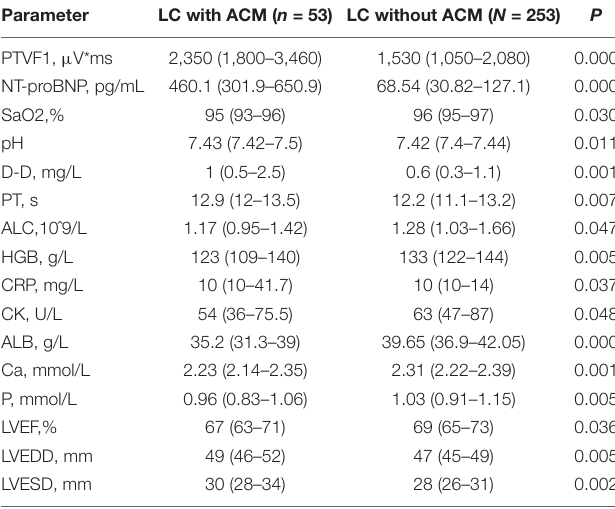
TABLE 6 | Comparison of baseline LC patients with/without ACM.